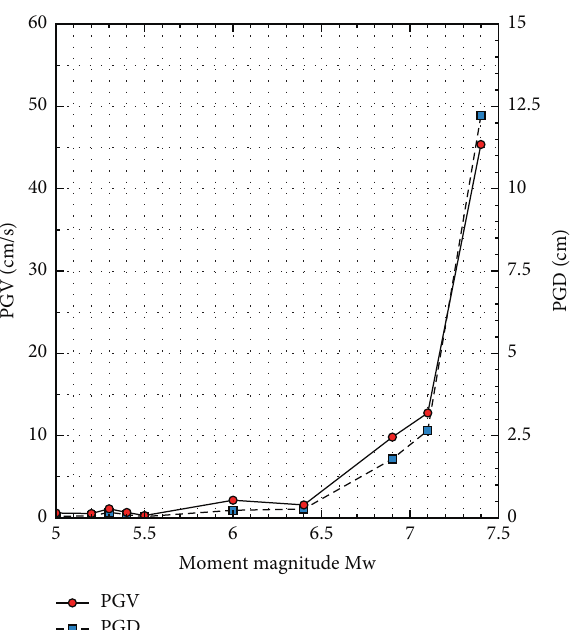
Figure 3: Variation with the earthquake magnitude of the mean peak ground velocity and peak ground